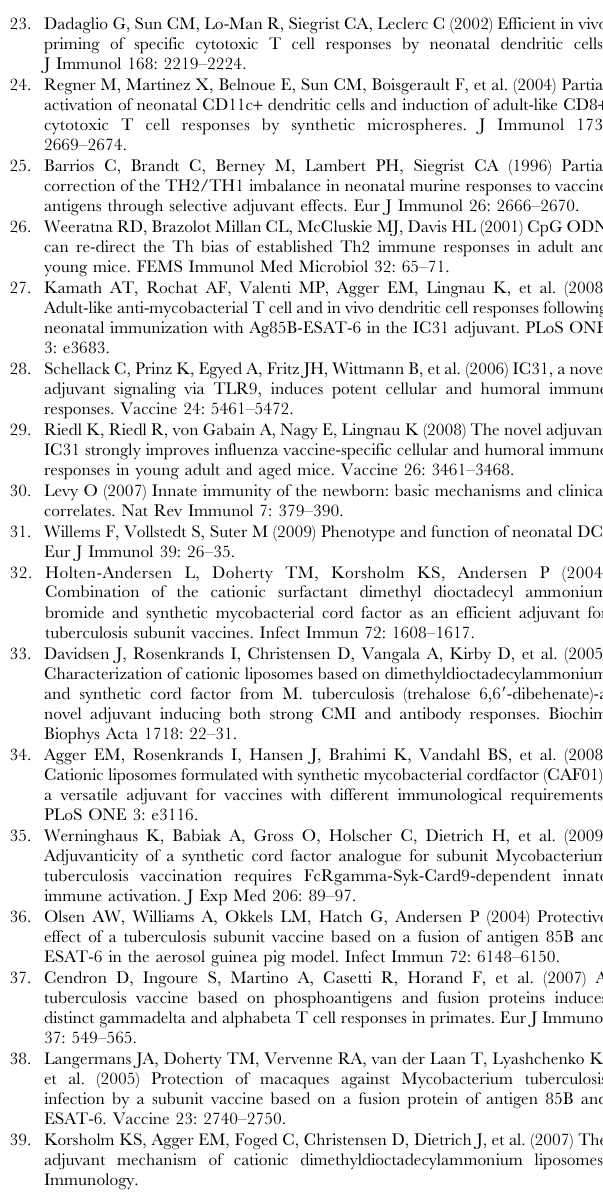
Figure 6. Targeted functional activation of DC in neonates and adults. Twenty-four hours after immunization, the expression of CD40 and CD86 by total DC and adjuvant + DC was assessed. (A) Histograms gated on CD11c + cells from adult mice immunized with Ag85B-ESAT-6/CAF01 represent the expression of co-stimulation molecules by total DC and CAF01 + DC. (B) The MFI is expressed as mean and SD of groups of at least 4 individual mice, and is representative of 4 independent